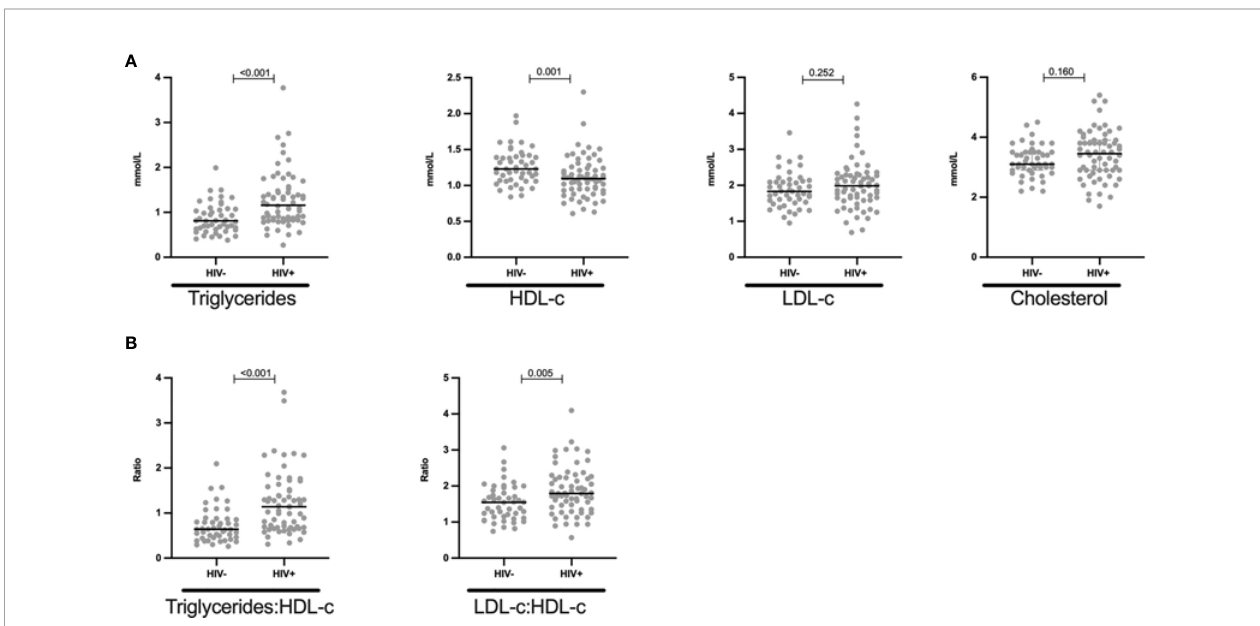
FIGURE 1 | Reduced HDL-c and increased triglycerides levels in HIV+ children: (A) Plasma quantity for triglycerides, HDL-c, LDL-c and cholesterol is shown in mmol/L and strati fi ed by HIV status. (B) Triglycerides-HDL-c ratio and LDL-c-HDL-c ratio is shown in HIV negative and HIV positive children. Each dot represents an individual volunteer, the median is indicated. Statistical analysis was performed using the Mann-Whitney